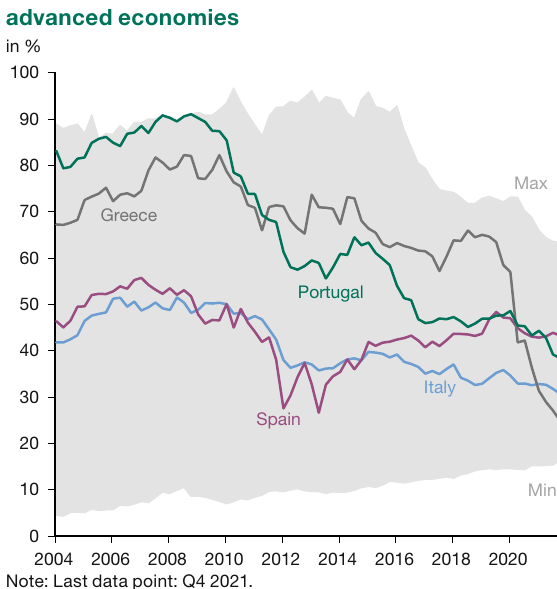
Note: Last data point: Q4